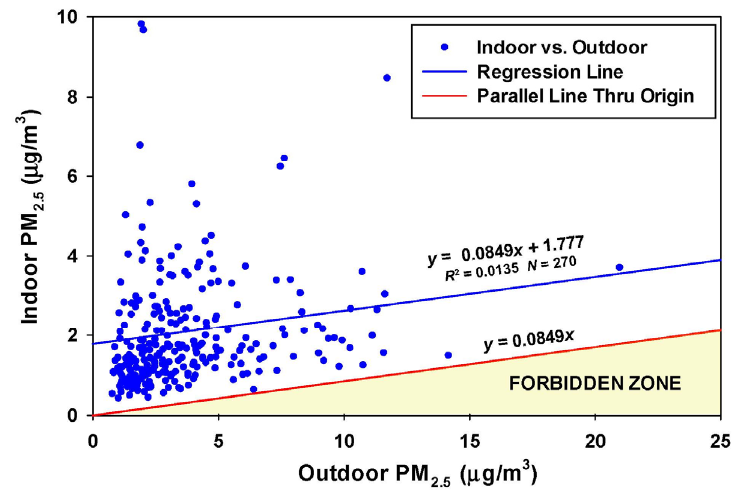
Figure 2. Regression of daily outdoor PM 2.5 on indoor PM 2.5 during the time the Menlo Park resi-